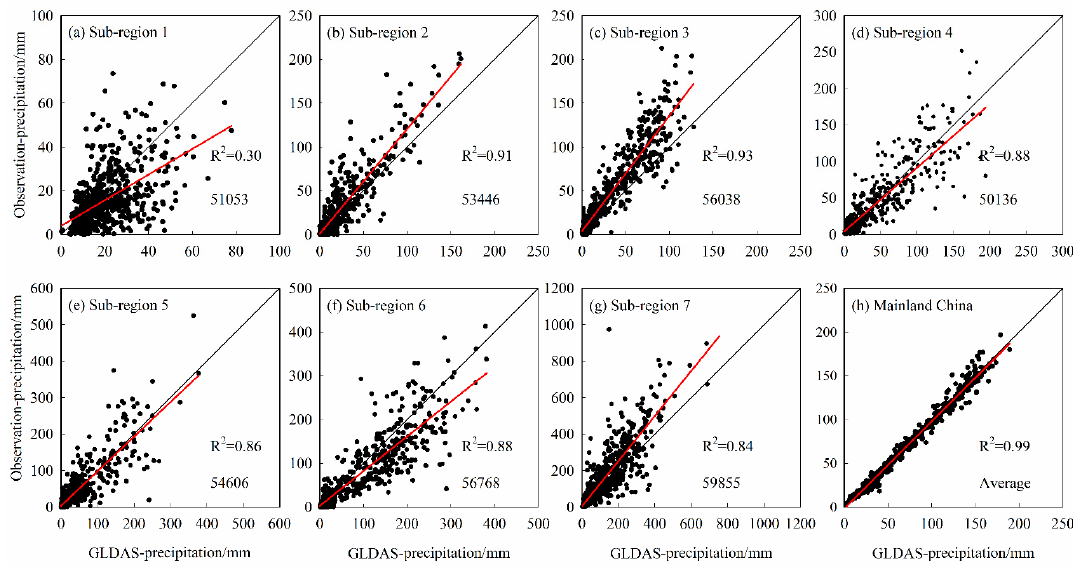
Figure 2. The scatter diagram of global land data assimilation system (GLDAS) and actual observed